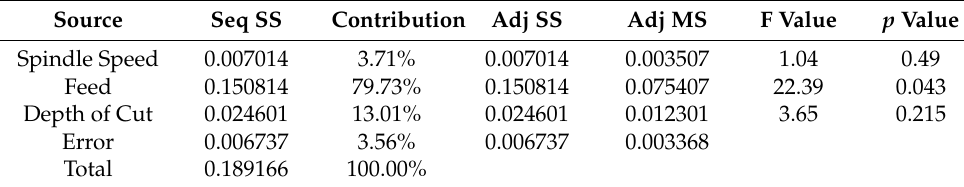
Table 12. Analysis of variance for transformed response for Ra.